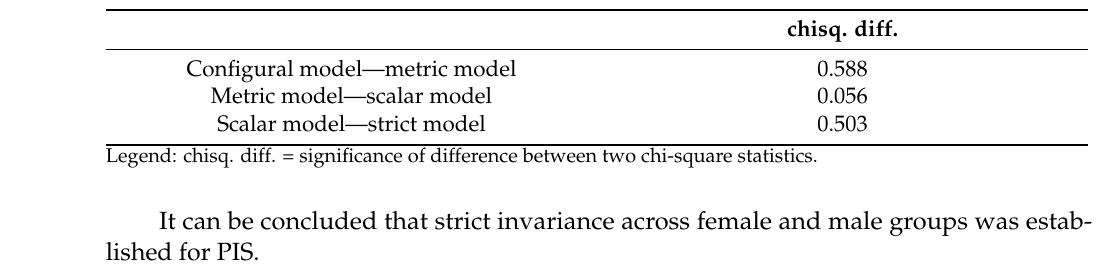
Table 7. Differences between chi-square statistics for gender.